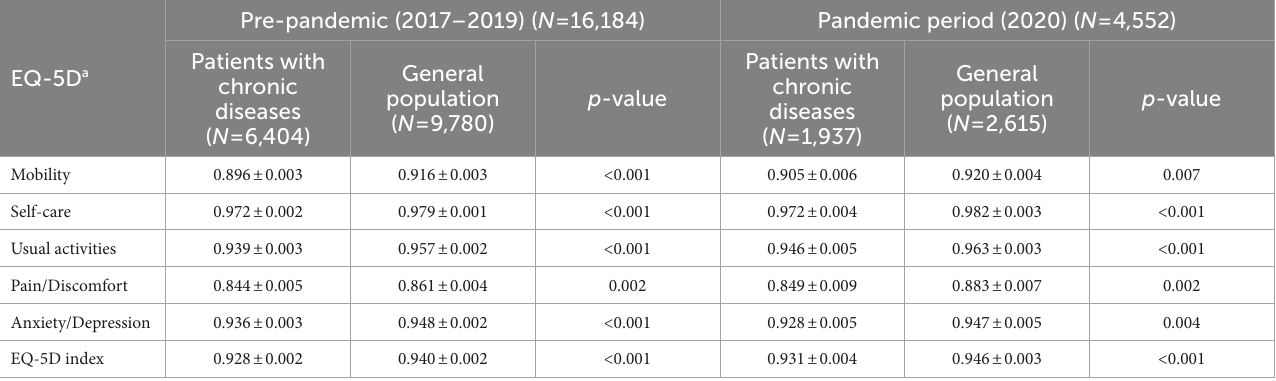
TABLE 2 Adjusted mean comparison of EQ-5D between patients with chronic diseases and the general population during the pre-and pandemic periods of the COVID-19.